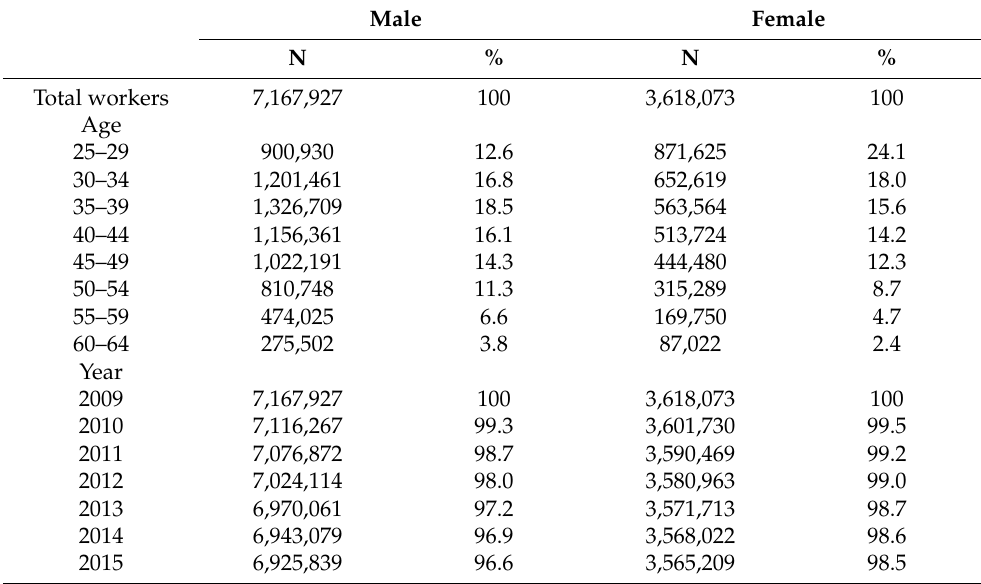
Table 1. Baseline distribution of age group and included number of